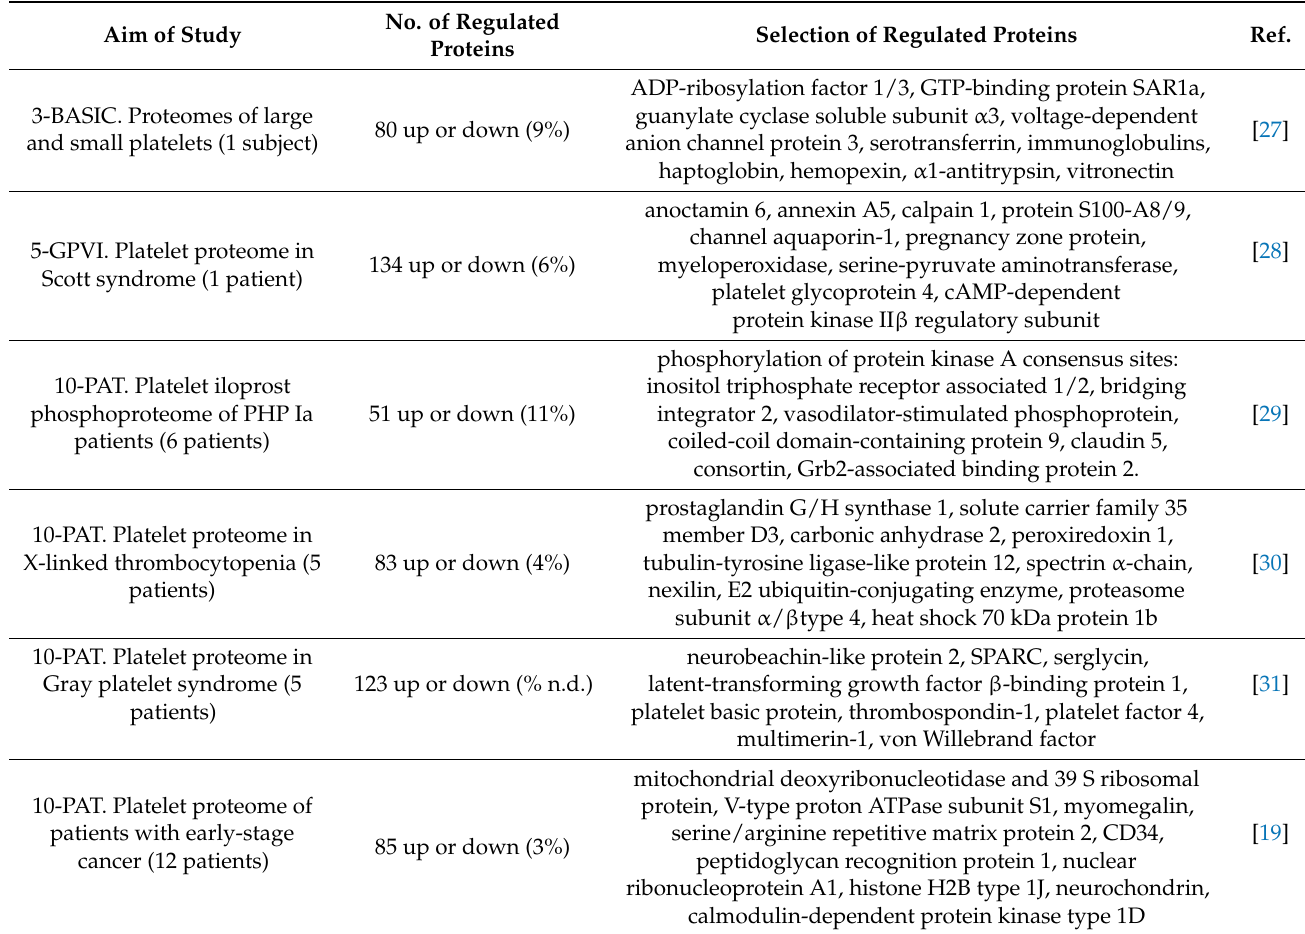
Table 2. Selection of protein changes in published platelet proteomes. Confined to papers showing abundant regulated proteins in platelet (fractions from) patients. Italic: plasma or secretory proteins [11]. No. of Regulated Selection of Regulated Proteins Aim of Study Proteins